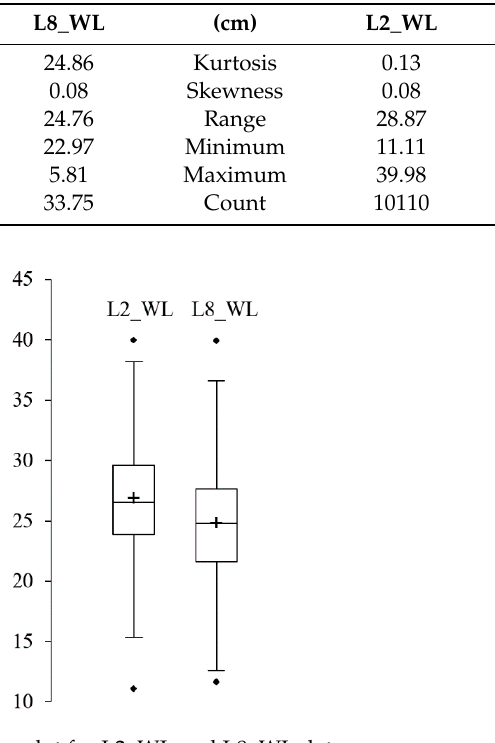
Table 1. Descriptive statistics for L2 and L8 water level data.